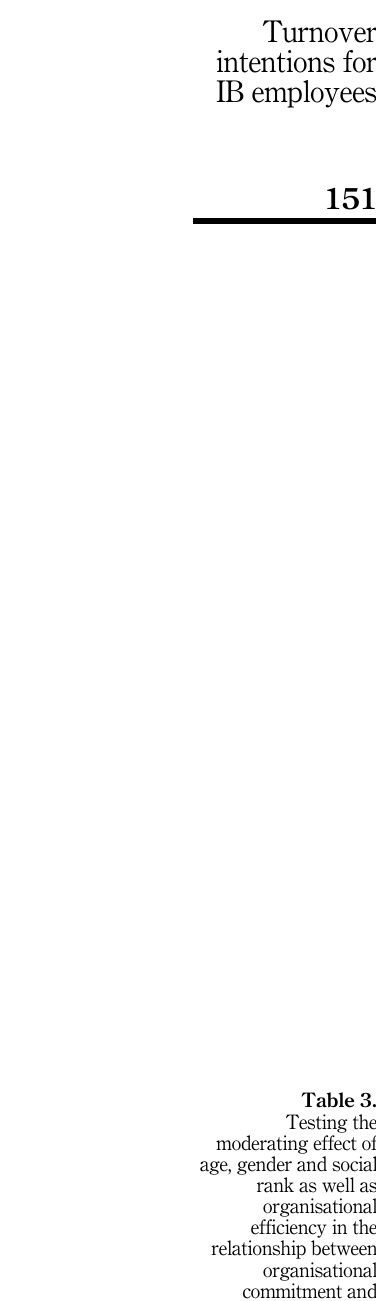
moderating effect of age, gender and